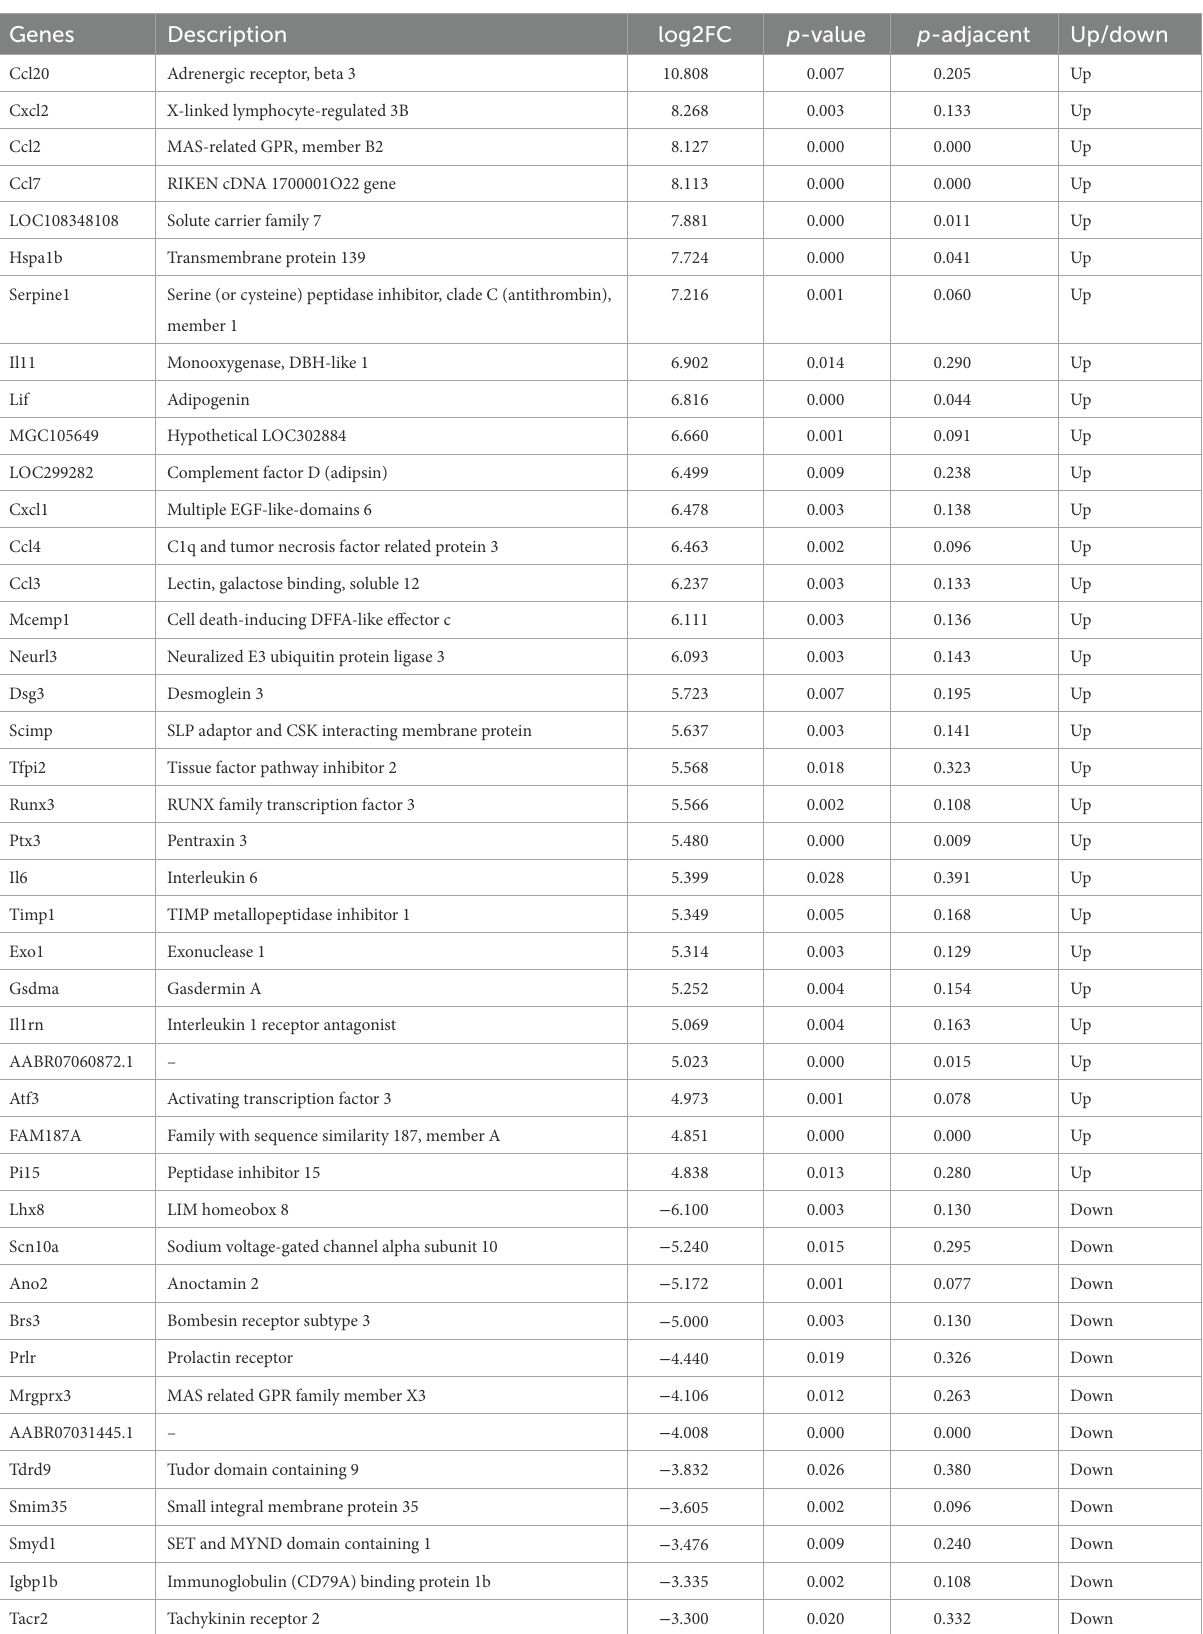
TABLE 1 Top 30 up-regulated DEGs and 10 down-regulated DEGs in the model rats.